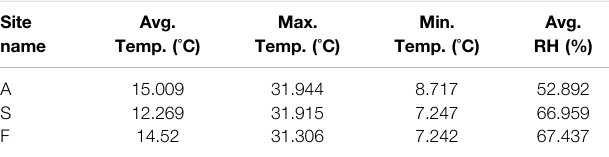
TABLE 3 | Summary of environmental temperatures and relative humidity in the different sites throughout the mission. Site